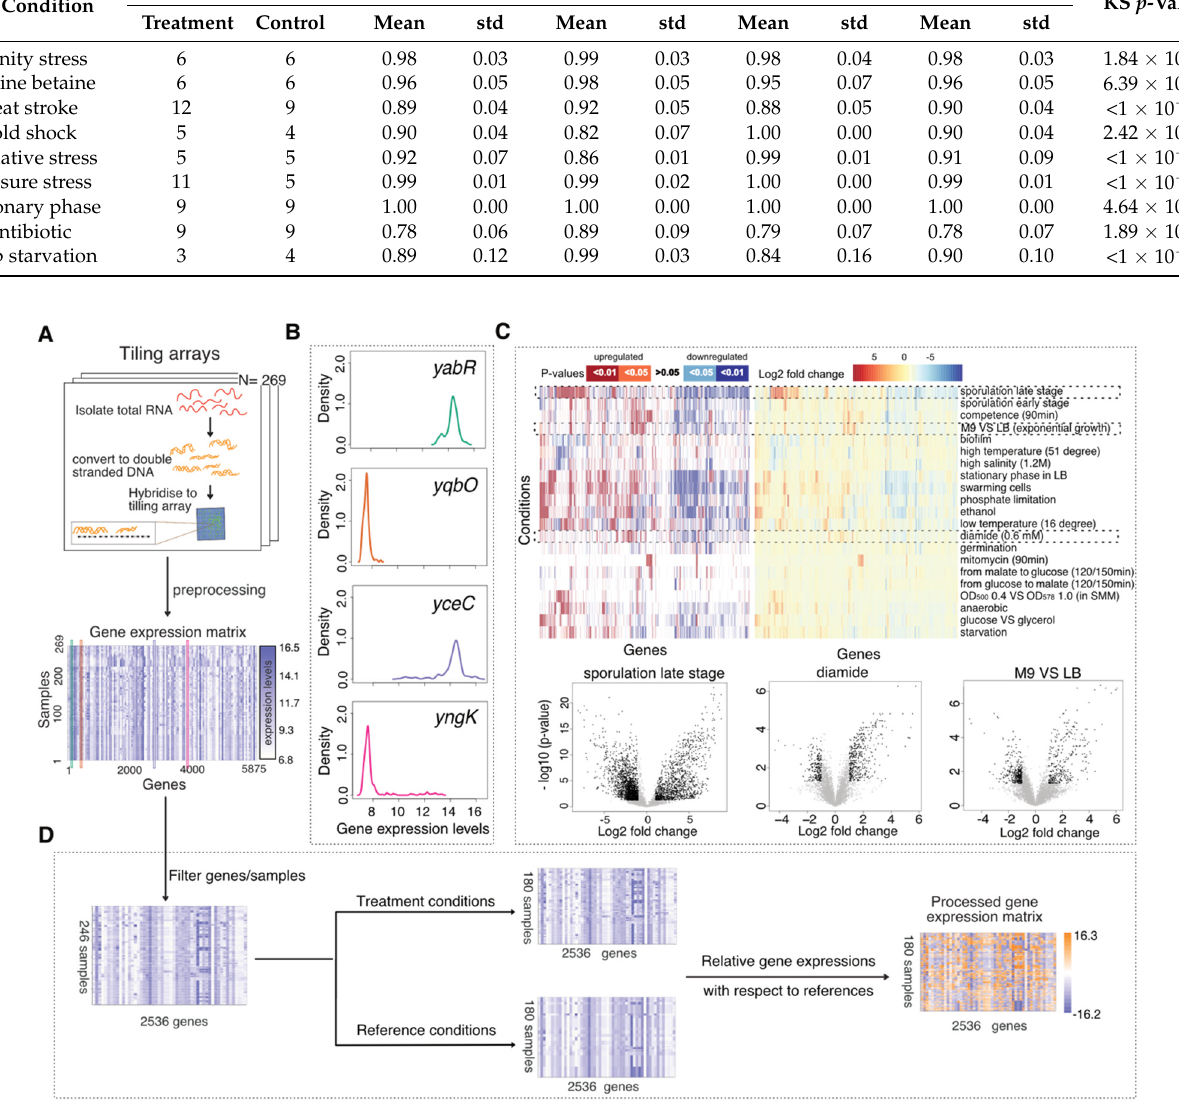
Figure 1. Tiling array data and data processing. ( A ) Tiling arrays which measured the RNA signals under various conditions were pre-processed to a gene expression matrix consisting of the gene expression levels of 5875 genes for 269 samples. ( B ) Different distribution patterns for gene expressions across samples. ( C ) p -Values and log2-fold-changes for the differential expression analysis performed on 21 pairs of contrasting growth conditions. Genes differentially expressed ( p -Value < 0.05, log-fold-change > 1) for three condition contrasts — sporulation late stage against pre-sporulation stage (S0 vs. S3 – S8), diamide treatment against non-oxidative environment (Oxctl vs. Diami), exponentially growing with glucose in M9 against in LB (LBGexp vs. M9exp) — are highlighted as black points, respectively. ( D ) Data processing steps include filtering some genes and samples, calculating the relative gene expression for treatment conditions with respect to their corresponding reference expressions. The processed gene expression matrix contains 180 samples and 2536 genes whose expression levels range from − 16.2 to 16.3.